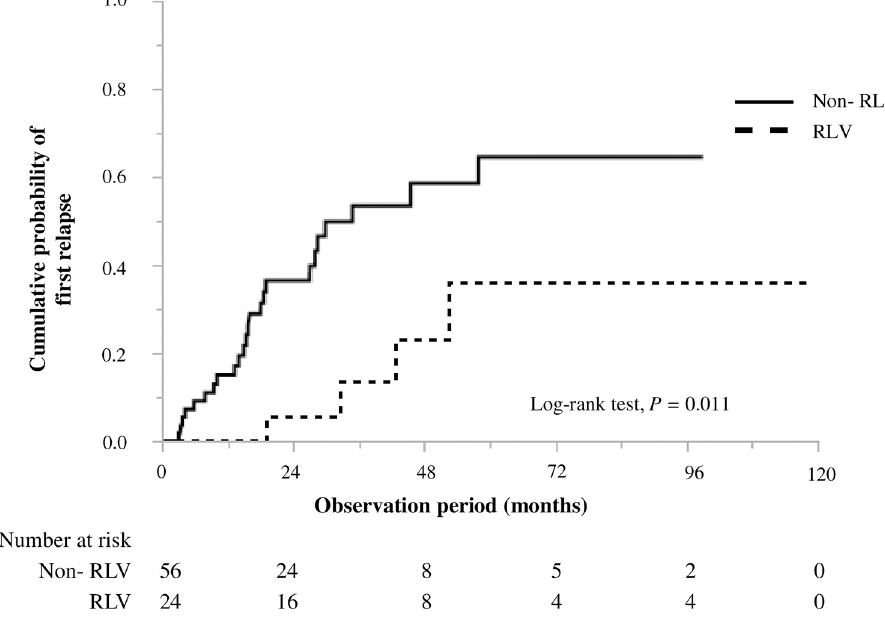
Fig 2. Cumulative probability of relapse in RLV and non-RLV groups. A significant difference was observed ( P = 0.011). RLV, renal-limited